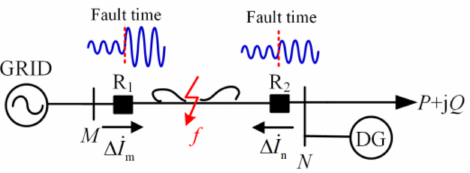
Figure 14. Schematic of FDSS for active distribution network feeder